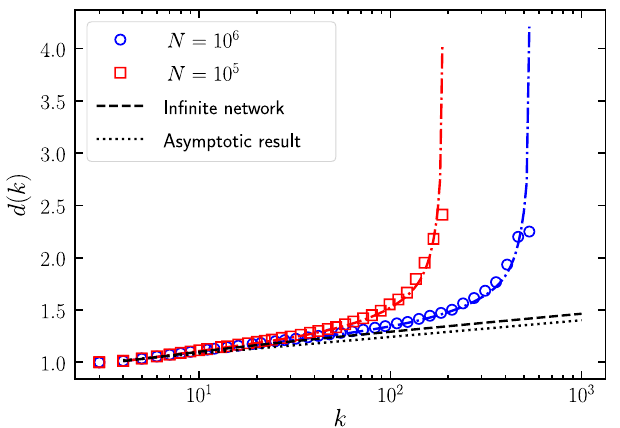
FIG. 9. Average distance between a node of degree k and the closest node of a degree at least k in power-law networks with degree exponent γ ¼ 3 . 2 . Symbols represent numerical simula- tions over networks of different sizes, averaged over 10 4 independent network samples. The dashed line represents the numerical evaluation of the summation Eq. (B6) in the infinite network limit. Dot-dashed lines represent results of the summa- tion for finite networks of the corresponding size N . The dotted line corresponds to the asymptotic expression Eq.